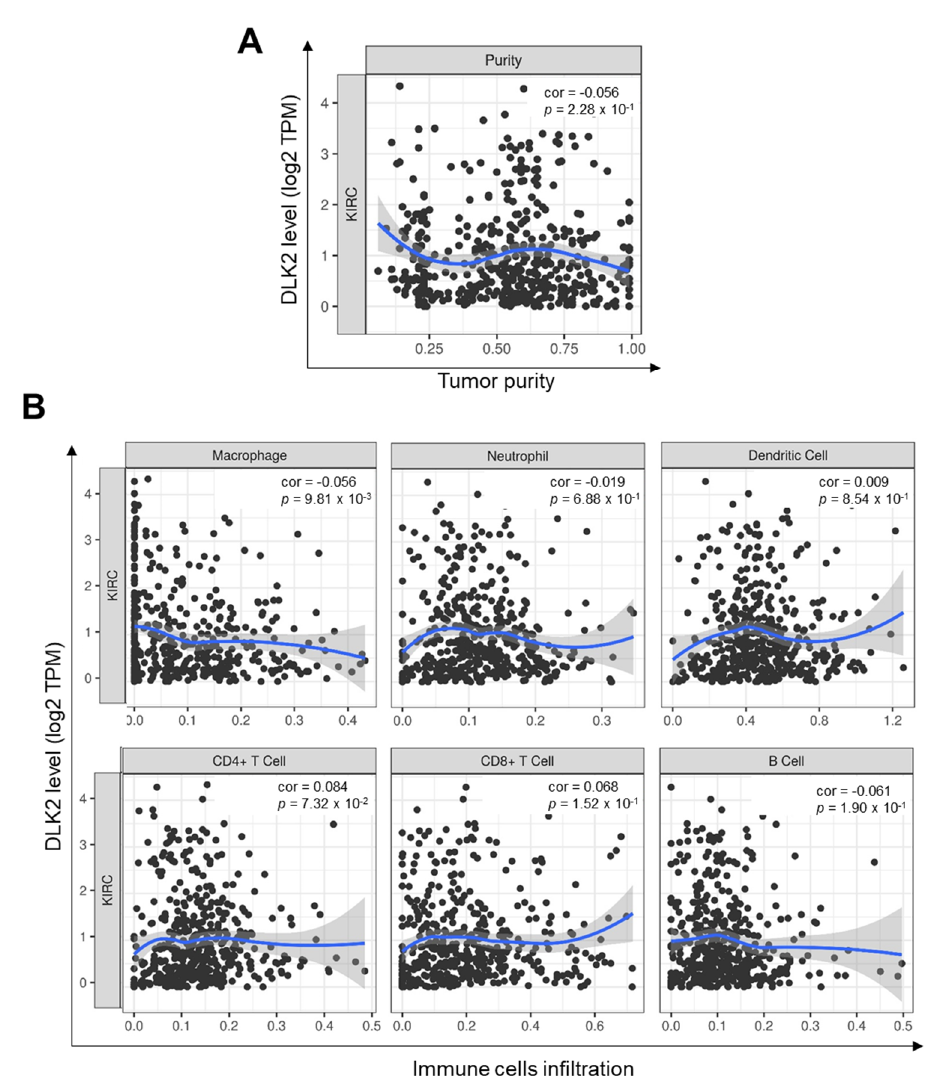
Figure 9. The correlation between DLK2 expression and immune cells infiltrations in ccRCC is analyzed using the TIMER database. ( A ) The correlation between the DLK2 level and tumor purity in ccRCC. ( B ) The correlation between the DLK2 expression and the recruitments of macrophages, neutrophils, dendritic cells, CD4 + T cells, CD8 + T cells, and B cells in ccRCC tissues.